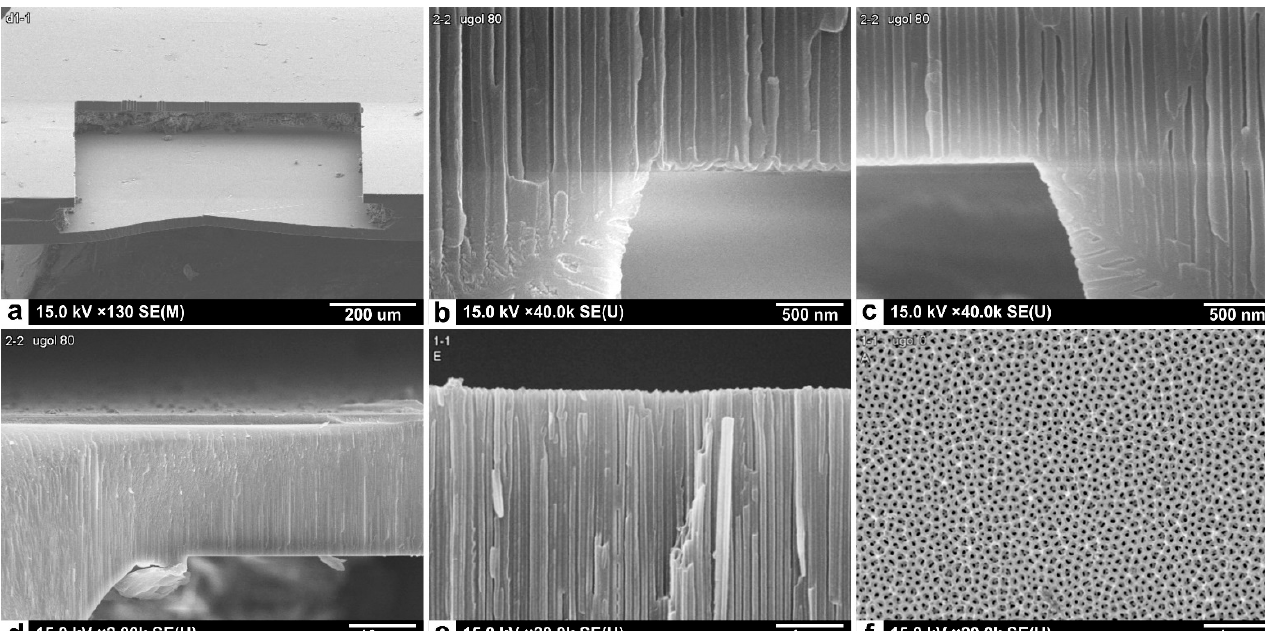
Figure 4. SEM images of the AA substrate with thin membranes: ( a ) image of the membrane from the back side of the substrate; ( b ) and ( c ) images of the transitions at the membrane–substrate interface; ( d ) image of the general view of the membrane cross-section; ( e ) image showing the microstructure of the porous AA substrate; and ( f )image showing the surface of the anodic alumina mem- brane.